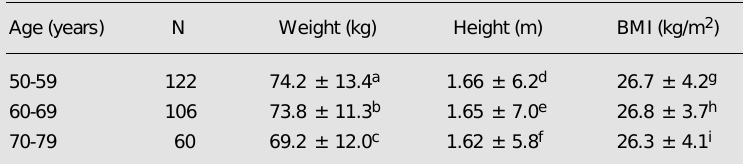
Table 3 - Clinical and demographic characteristics of 288 healthy Brazilian men strati- fied by decade.